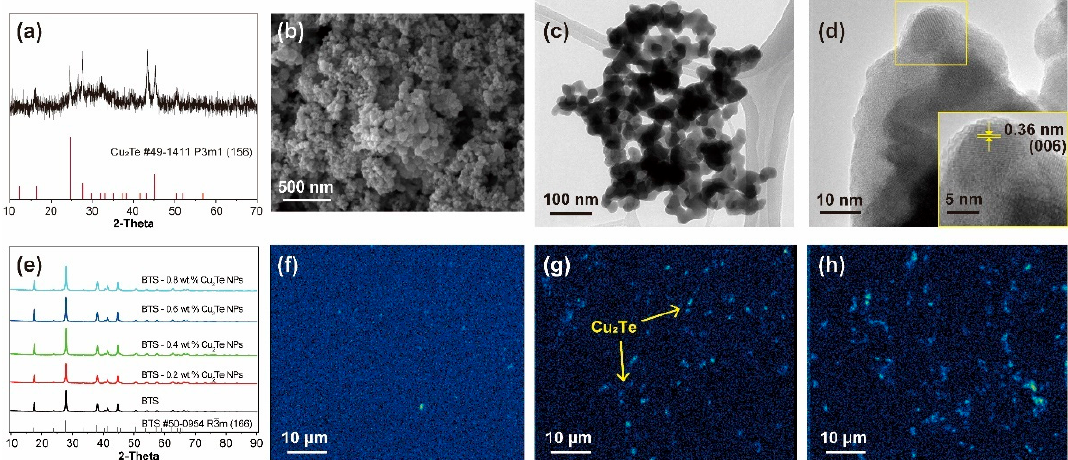
Figure 1. ( a ) XRD pattern, ( b ) SEM image, ( c ) TEM image, and ( d ) high resolution TEM image of Cu 2 Te NPs, ( e ) XRD patterns of BTS ‐ x wt.% Cu 2 Te NPs ( x = 0, 0.2, 0.4, 0.6, and 0.8), Cu K mapping images of EPMA for ( f ) BTS ‐ 0.2 wt.% Cu 2 Te NPs, ( g ) BTS ‐ 0.4 wt.% Cu 2 Te NPs, and ( h ) BTS ‐ 0.6 wt.% Cu 2 Te NPs, where the light dots correspond to elemental Cu. Table 1. The lattice parameters of BTS- x wt.% Cu 2 Te NPs ( x = 0, 0.2, 0.4, 0.6, and 0.8). Table 1. The lattice parameters of BTS ‐ x wt.% Cu 2 Te NPs ( x = 0, 0.2, 0.4, 0.6, and 0.8). Lattice Constant for a (Å) Lattice Constant for c (Å) Lattice Constant for a (Å) Lattice Constant for c (Å)